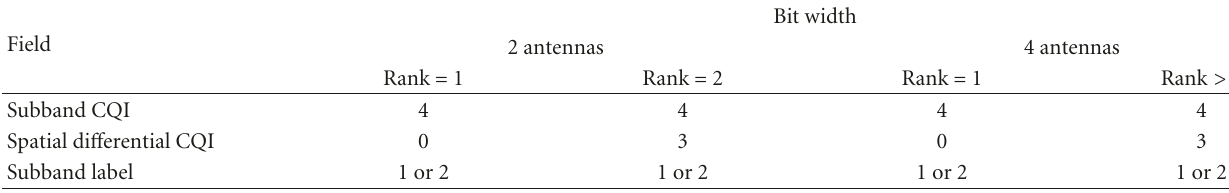
Table 10: Feedback of subband CQI via